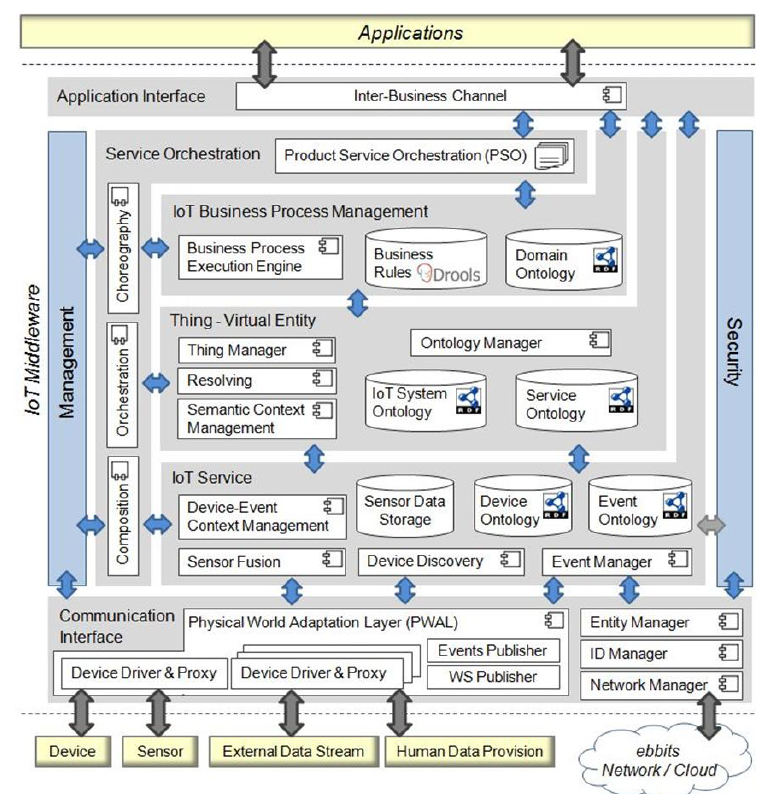
Figure 1. Modular architecture of the LinkSmart IoT middleware in the EBBITS project. Image from Furdik et al.